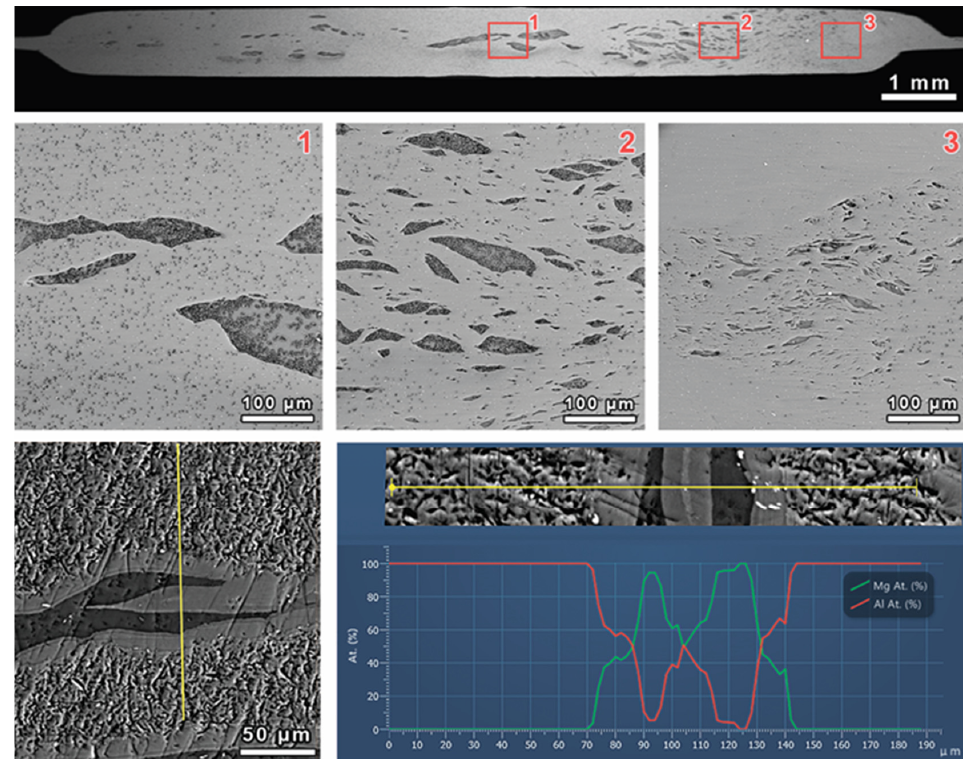
Figure 2. SEM images (BSE mode) of the Al-Mg nanostructured composite cross-section at different magnifications and element distribution along the line shown at the top of the panel in the form of a relative intensity plot in relation to the scanning distance of the Mg and Al, marked by green and red, respectively.